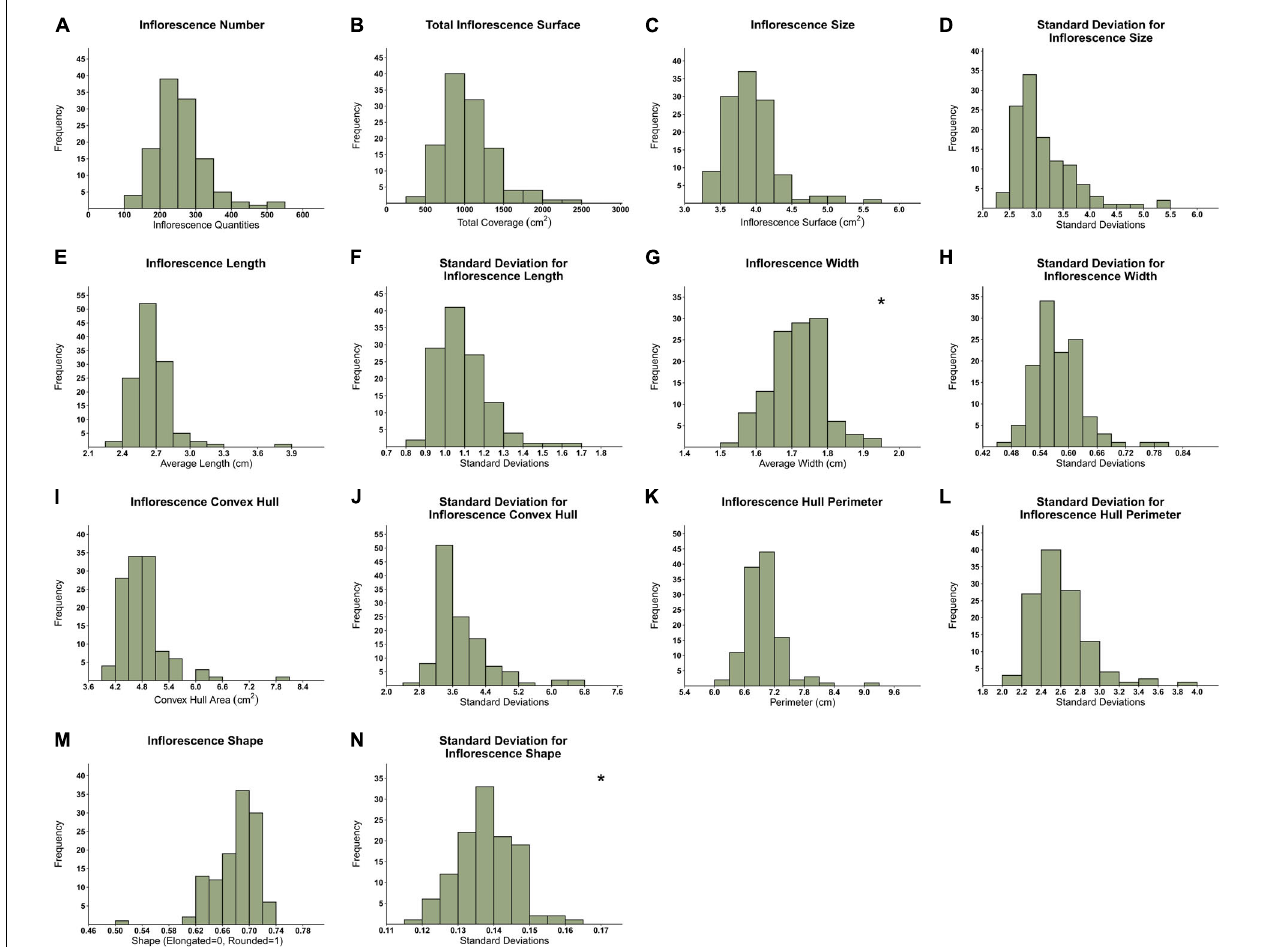
FIGURE 4 | Frequency distribution of 119 genotypes across 14 inflorescences’ attributes. (A) Inflorescence Number (IN), (B) Total Inflorescence Surface Coverage (TIC), (C) Average Inflorescence Size (IS), (D) Inflorescence Size standard deviation (IS.sd), (E) Average Inflorescence Length (IL), (F) Inflorescence Length standard deviation (IL.sd), (G) Average Inflorescence Width (IW), (H) Inflorescence Width standard deviation (IW.sd), (I) Average Inflorescence Convex Hull (CH), (J) Inflorescence Convex Hull standard deviation (CH.sd), (K) Average Inflorescence Hull Perimeter (HP), (L) Inflorescence Hull Perimeter standard deviation (HP.sd), (M) Inflorescence Shape (ISH), (N) Inflorescence Shape standard deviation (ISH.sd). *Normally distributed figures marked with an asterisk on the top right